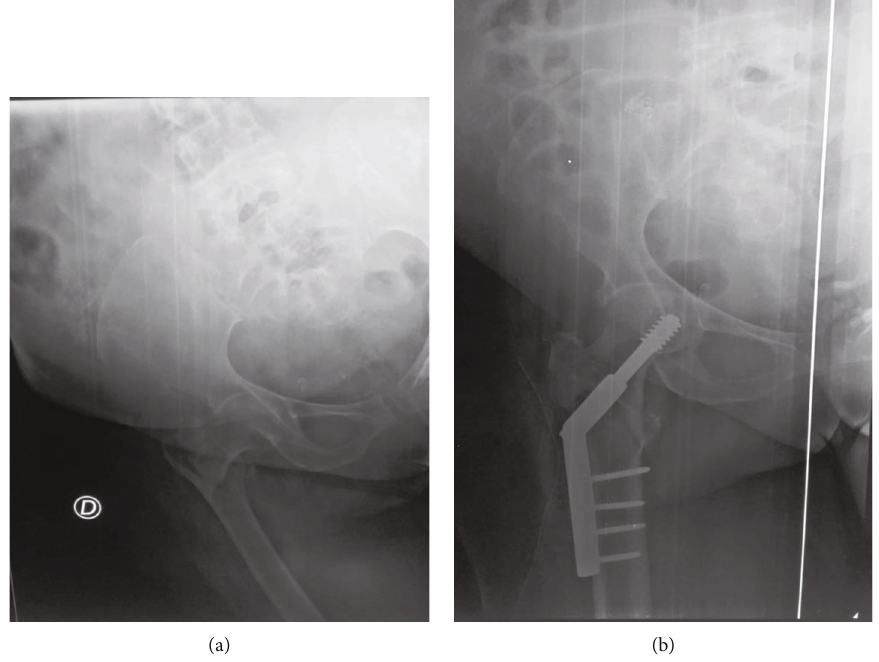
Figure 4: X-rays of patient 4. (a) Pertrochanteric fracture type 31A1.3 AO/OTA. (b) Osteosynthesis by DHS.